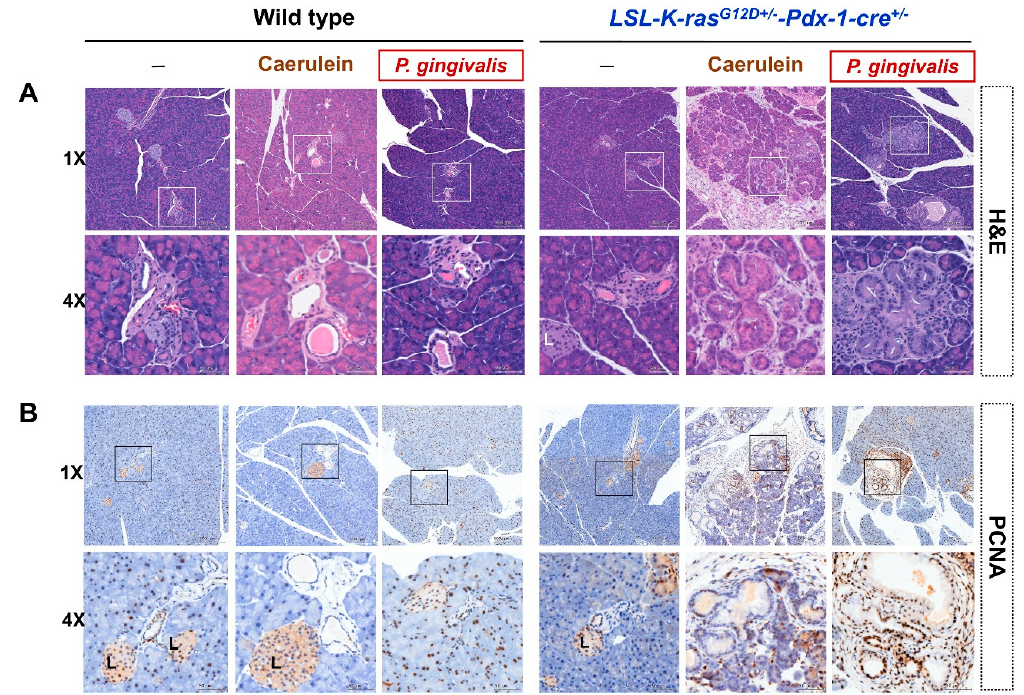
Figure 3. Representative images of pancreatic histology in non-treated mice, caerulein-treated mice, and P. gingivalis- treated mice at four weeks after treatment. ( A ) H and E staining (upper scale bar, 200 µ m; lower scale bar, 50 µ m). ( B ) PCNA staining (upper scale bar, 200 µ m; lower scale bar, 50 µ m). L, langerhans islets; PCNA, proliferating cell nuclear antigen.